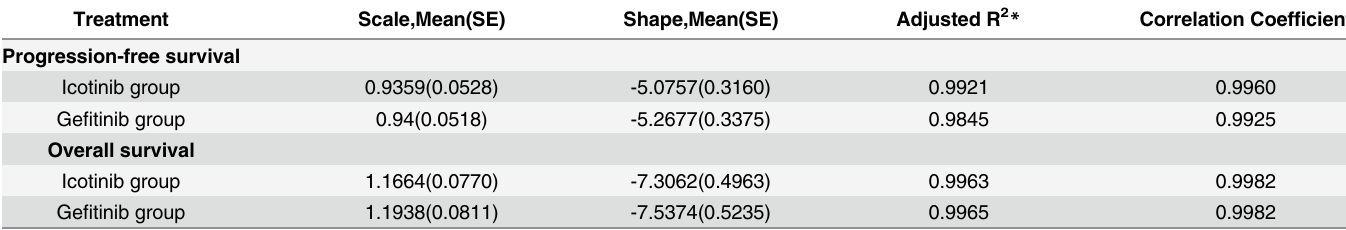
Table 3. Parameters of Weibull models fitted to the Kaplan-Merier survival curve in the trial. Treatment